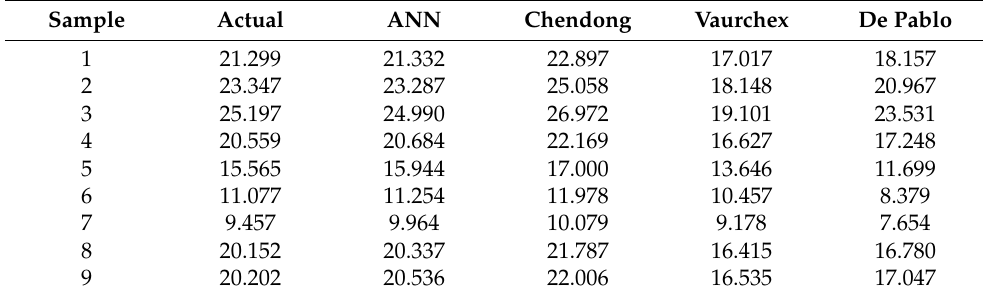
Table 4. Transformer case studies: Consumed Lifetime.